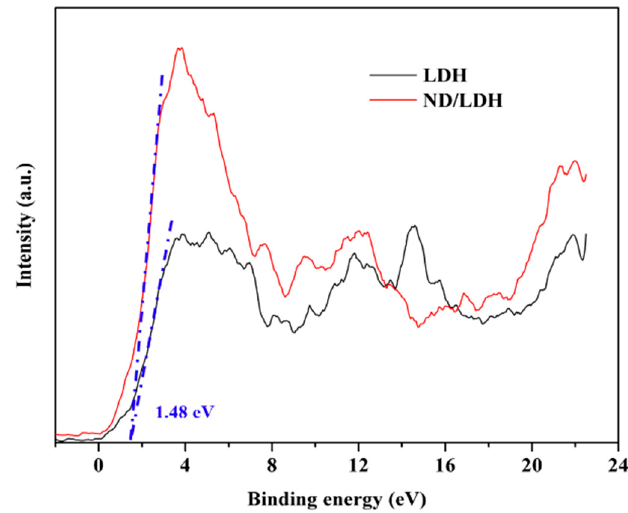
Figure 12. Valence band (VB) XPS spectra of LDH and ND/LDH.